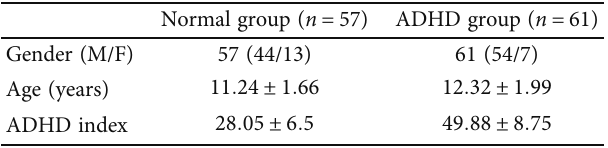
Table 1: Demographic and clinical characteristics of all the